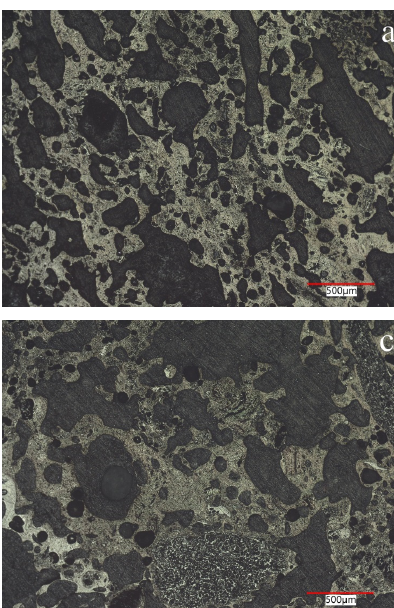
Figure 4. Images of the coke sample. ( a ) Optical image of the coke sample, magni fi cation 100×; ( b )